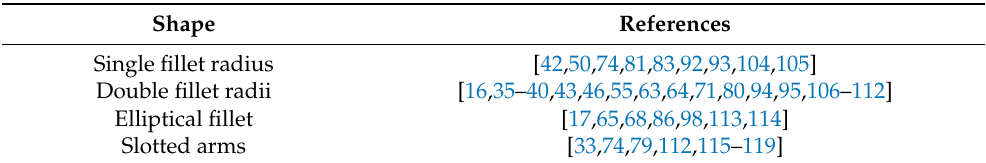
Table 1. Preferred shape for corner between adjacent arms in experimental biaxial tests with cruci- form